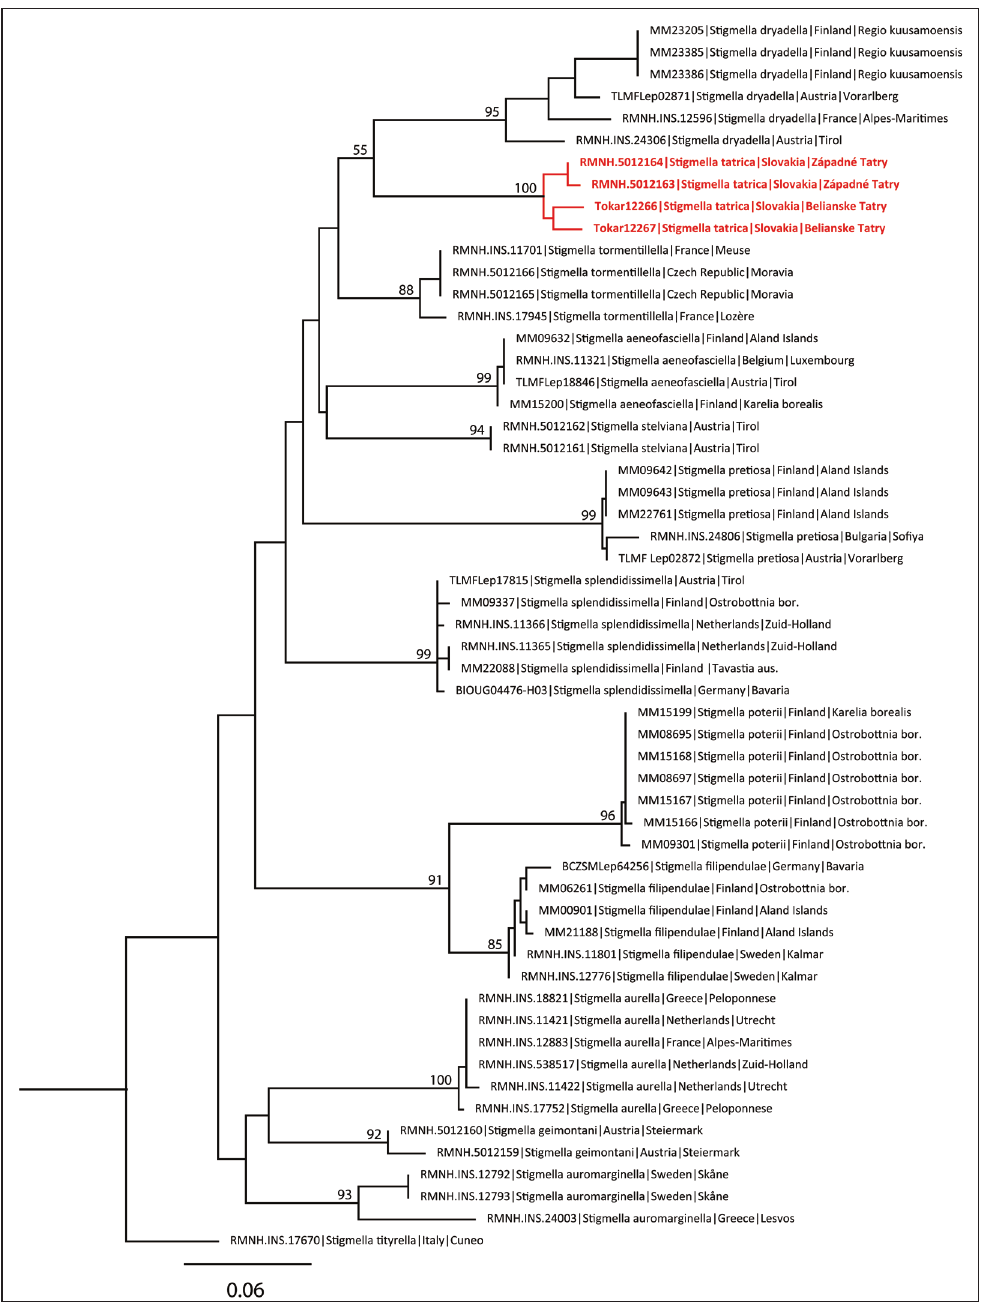
Figure 11. Maximum likelihood tree of European species of the Stigmella aurella group, showing the position of Stigmella tatrica in red. Small figures represent bootstrap values, after 100 replicates. Bootstrap values below 50 are not given. A specimen of Stigmella tityrella is used as outgroup. Nomenclature follows van Nieukerken et al.